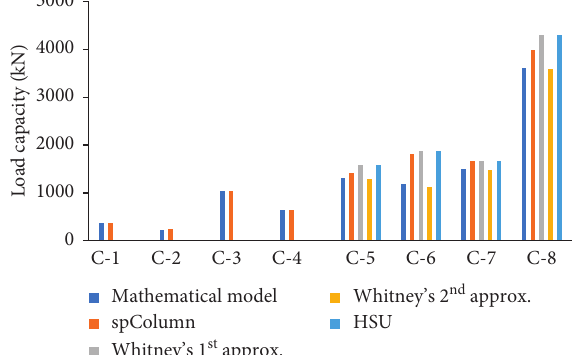
Figure 11: Axial load capacity comparison for uniaxial columns (C1–C8).